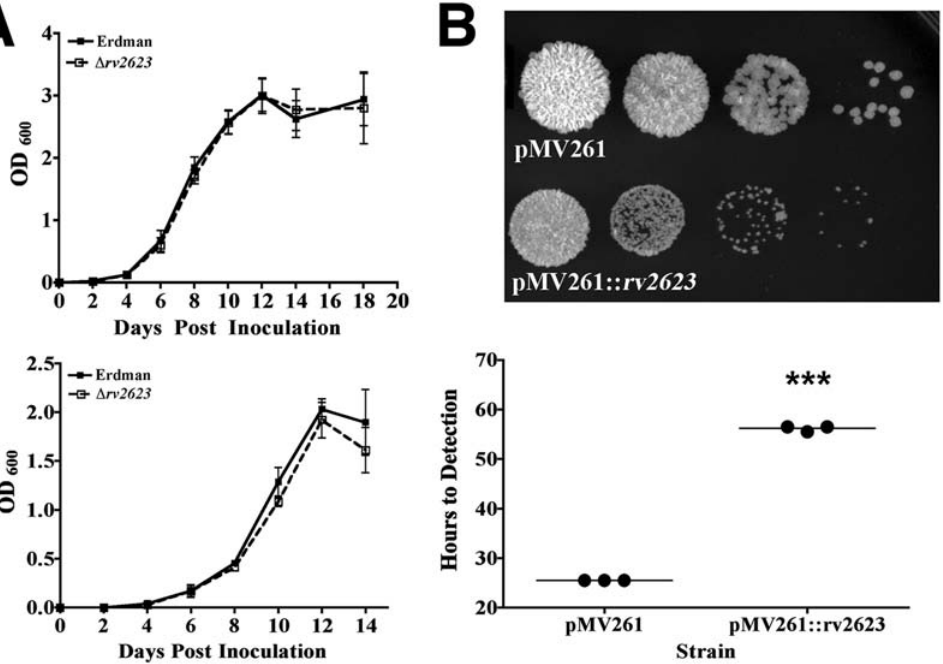
Figure 2. Invitro characterization of D rv2623 . (A) Growth curves of cultures inoculated (10 6 CFU/ml) into 7H9 + 10% OADC + 0.05% Tween 80 (top) and in minimal Sauton’s media (bottom); Erdman (closed boxes, solid line) and D rv2623 (open boxes, dashed line) cultures. Error bars represent the standard error of the means; each curve is a combination of at least three independent experiments. (B) Overexpression of Rv2623 in M. smegmatis . The top panel represents serial dilutions (1:10) of the empty vector pMV261-containing negative control strain and Rv2623-overexpressing strain harboring pMV261:: rv2623 . Diluted stationary phase M. smegmatis culture was spotted (5 m l) onto solid 7H10 media supplemented with 10% OADC and kanamycin (40 m g/mL). Photographs were taken after three days incubation at 37 u C. Growth of corresponding strains in liquid medium was assessed based on the time to detection determined using a BD BACTEC 9000MB system (bottom). The various strains were inoculated at 10 4 CFU/ml in triplicates. Data shown are representative of several independent experiments. ***p ,